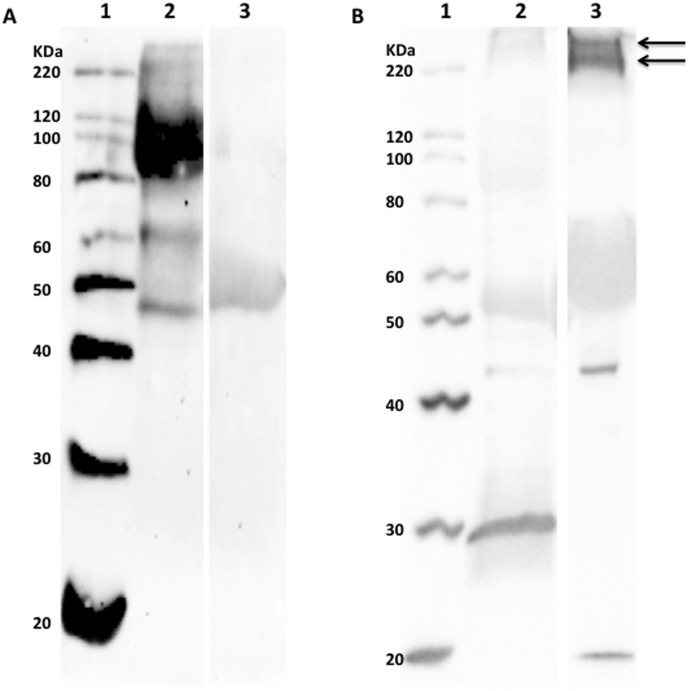
Absence of F4ac fimbriae binding to immunoprecipitated intestinal MUC13.Intestinal MUC13 was purified from 1 mg F4ab/acR+ brush border membrane vesicles (BBMVs) by immunoprecipitation with anti-MUC13 antibodies and protein A sepharose. The eluate (lane 2) and the non-precipitated fraction (lane 3) were immunoblotted with anti-MUC13 antibodies (A) or with F4ac fimbriae (B). Immunoprecipitation enriched a protein with a band of 110 kDa but this was not recognized by F4ac fimbriae. The F4-specific high MW glycoproteins were found in the non-precipitated fraction. Lane 1  =  protein standards. Arrows: position of the high MW glycoproteins.